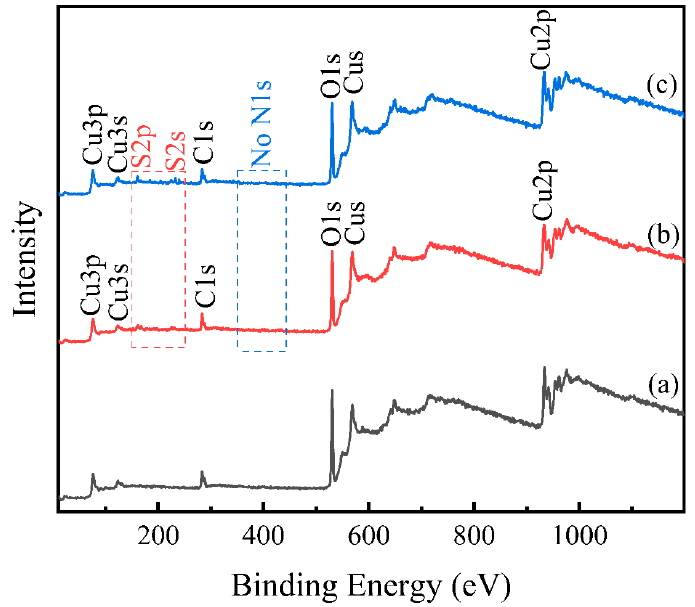
Figure 10. XPS survey spectra as follows: ( a ) pure malachite, ( b ) treated with Na 2 S and ( c ) treated with (NH 4 ) 2 S, Na 2 S = 6 × 10 − 2 mol/L, (NH 4 ) 2 S = 6 × 10 − 2 mol/L.